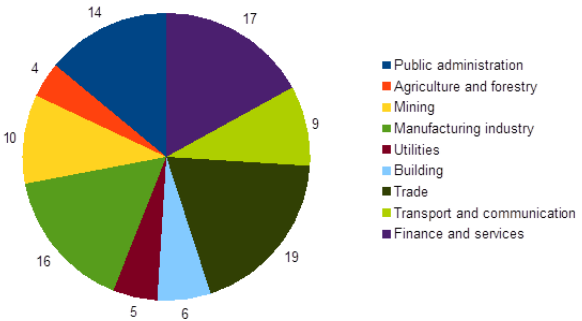
Fig. 1. The main components of the country’s